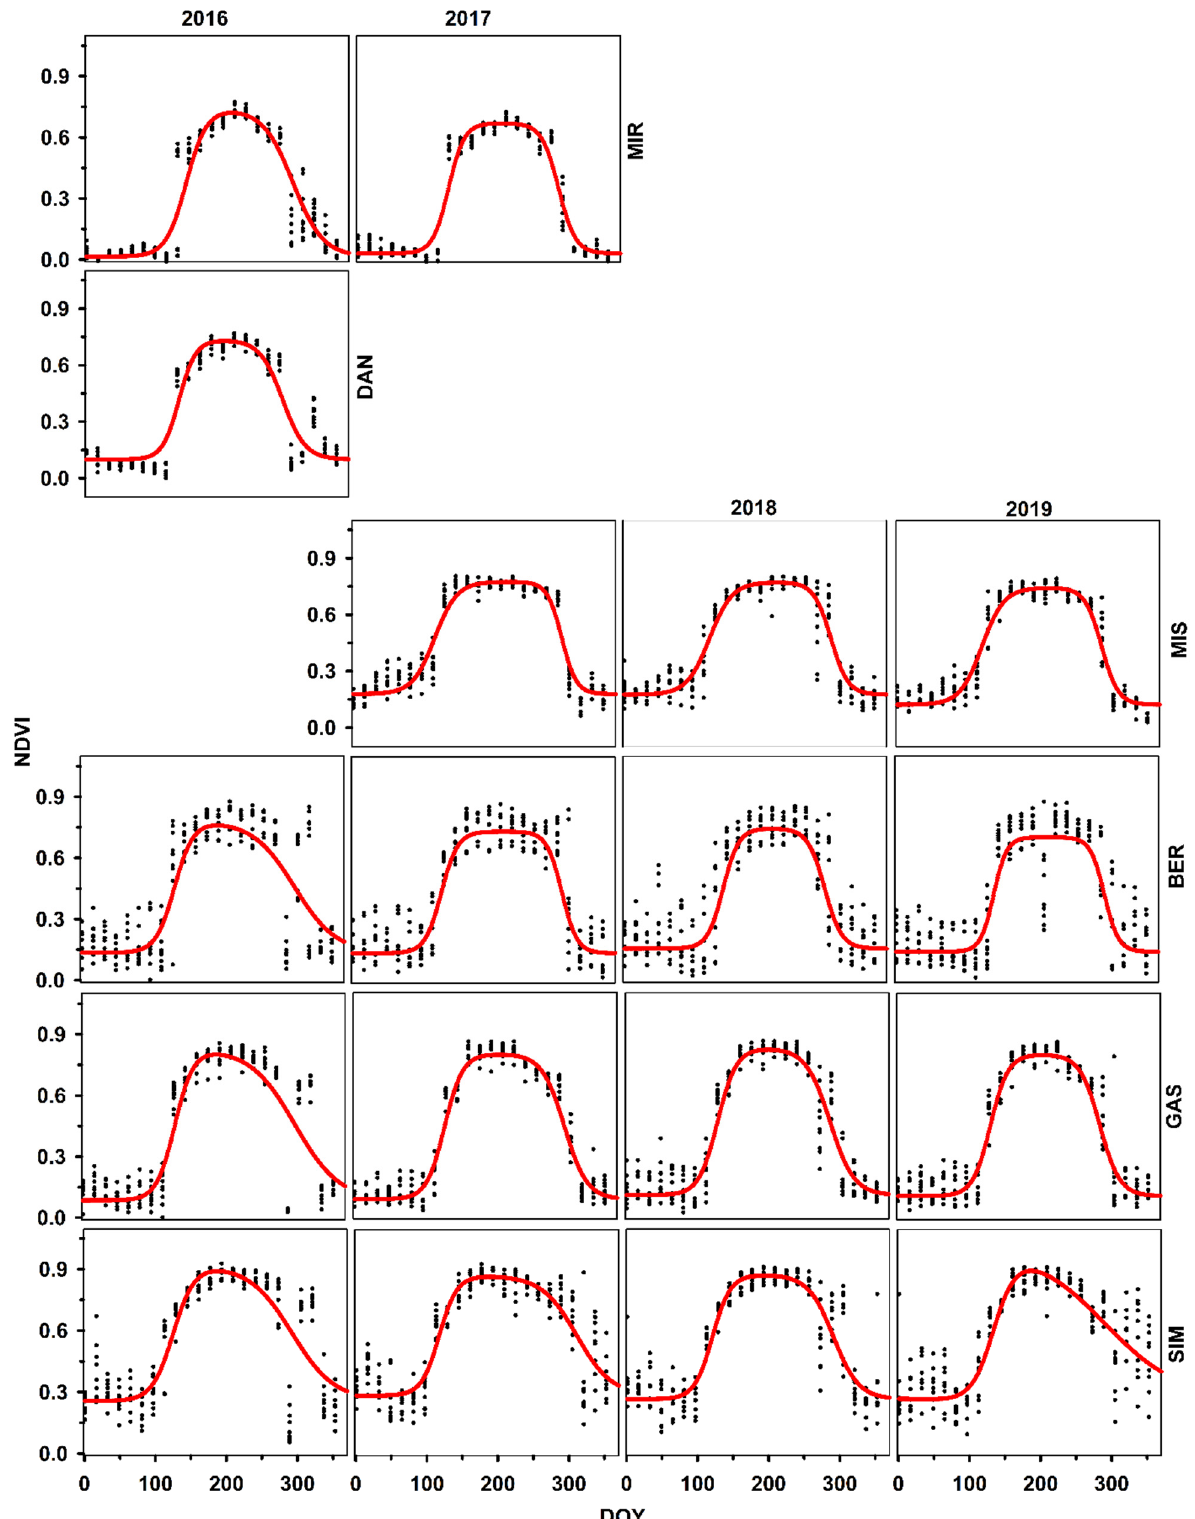
Figure 4. Time series of MODIS-NDVI for different sites along the latitude in Quebec for black spruce trees. Provenances are listed according to increasing latitude of the stands of origin.